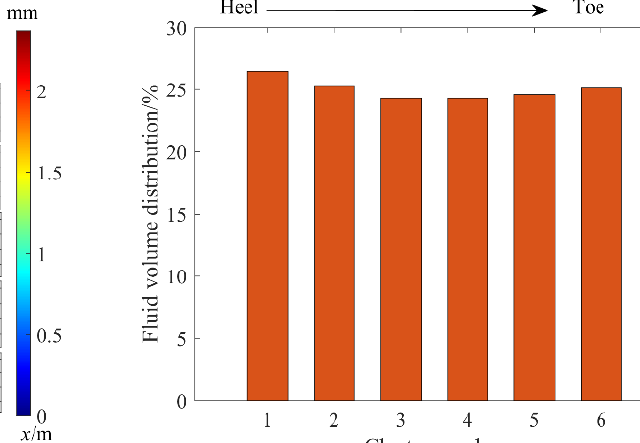
Figure 11. Variation coefficients of fluid allocations at different perforation diameters.